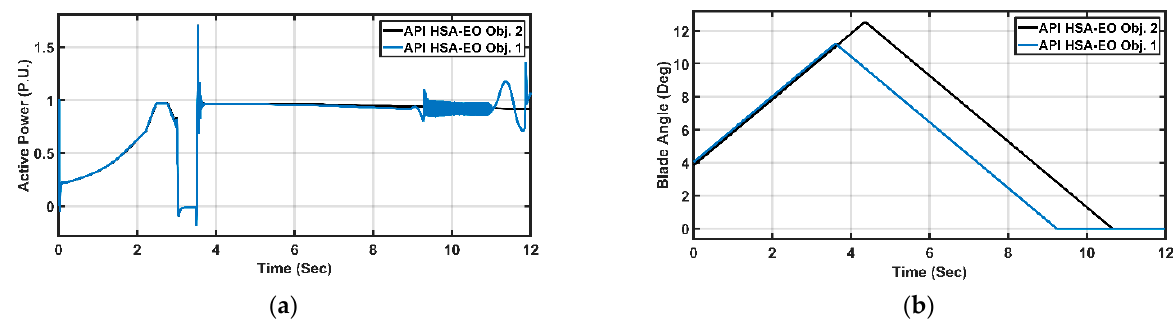
Figure 28. Wind-speed profile of faulty second case.